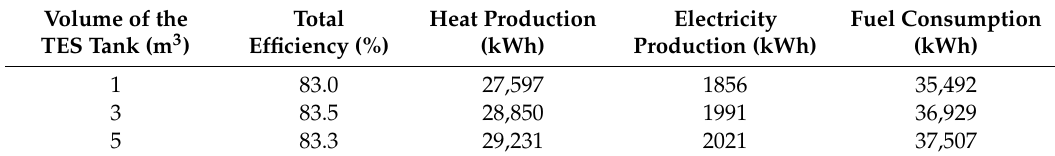
Table 1. The calculation results of the mCHP unit with three different tank sizes, which operated within one year.